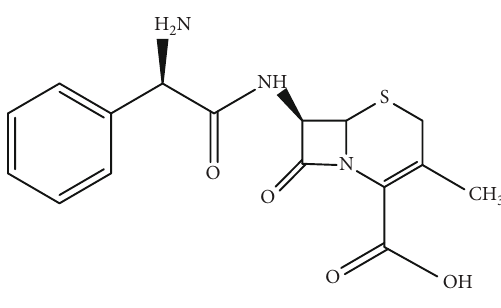
Figure 1: The chemical structure of